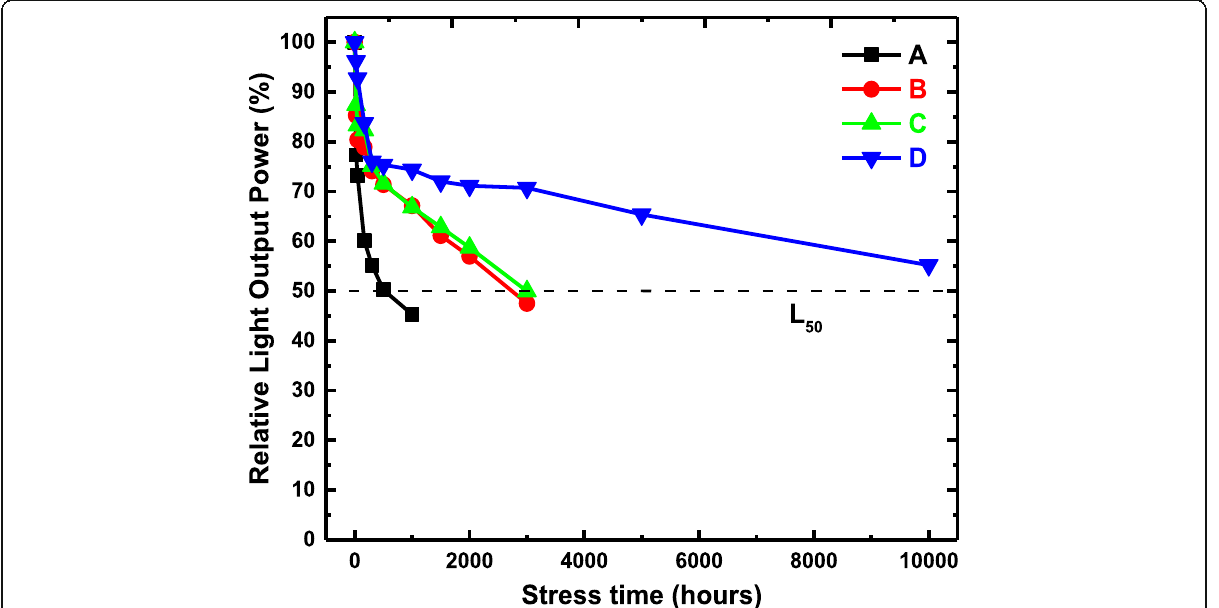
Fig. 5 The relative LOP as a function of the aging time for all the samples at 20 mA and room temperature. The aging is stopped when the relative LOP is under 50%. Black, red, green, and blue curves represent samples a , b , c , and d , respectively. The lifetime for sample D with ascending Al-content chirped SEDL is over 10,000 h at